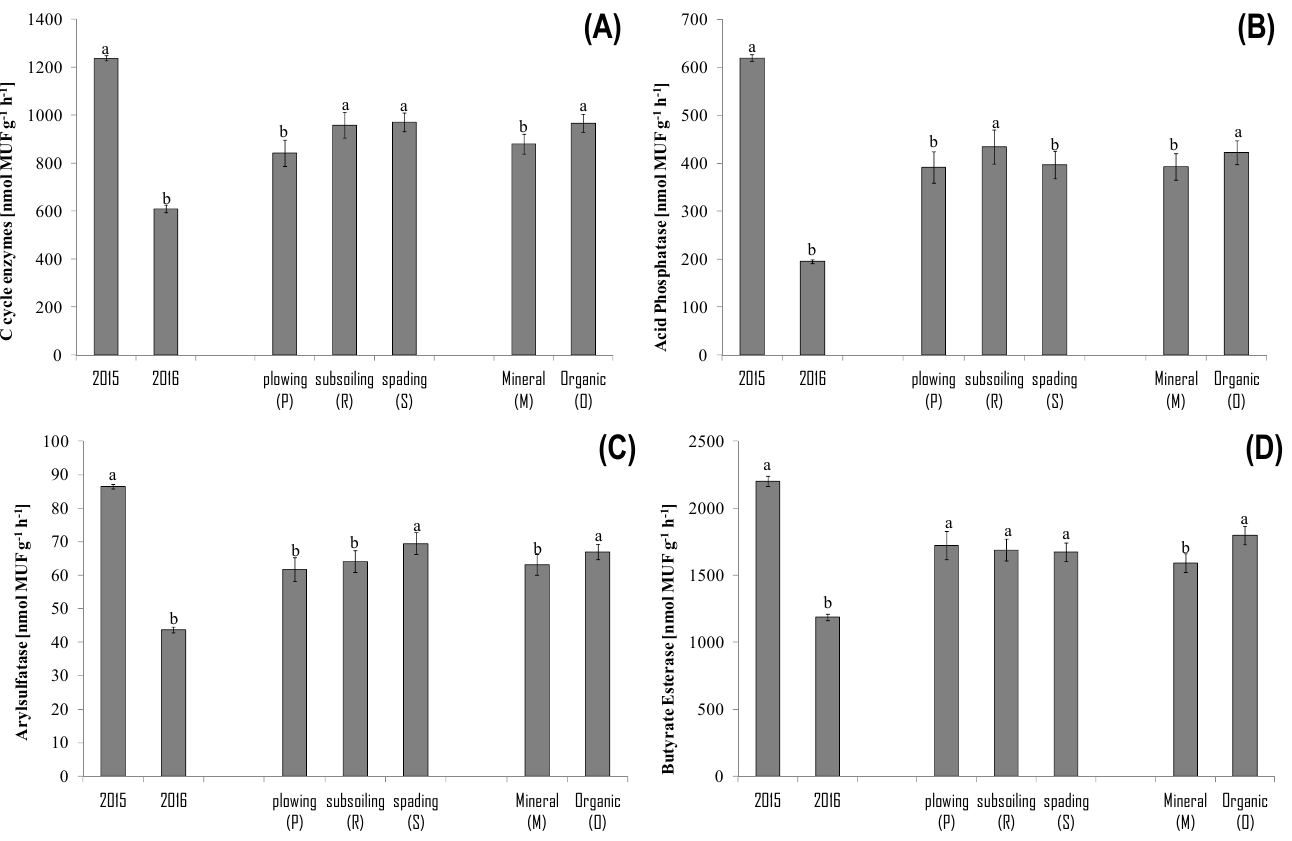
Figure 2. Soil enzyme activity in the main treatments (year of experiment, tillage and fertilization): ( A ) enzyme activities involved in C cycle, ( B ) acid phosphatase, ( C ) butyrate esterase, and aryl- sulfatase ( D ). Different letters indicate significant differences ( p < 0.05), bars are standard errors ( n = 3).